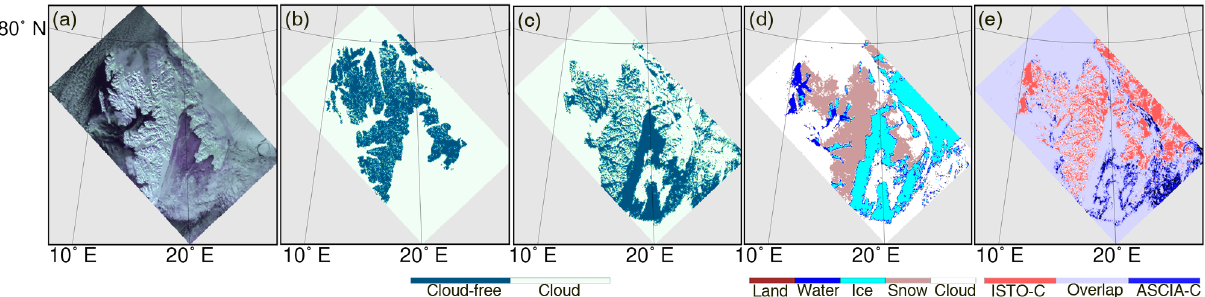
Figure 8. (a) The RGB false-colour image (using 0.67, 0.87 and 0.55µm channels) of AATSR over Svalbard, 18 March 2008; (b) nadir cloud flag from the AATSR L2 product; (c) cloud detection based on the spectral shape of clear snow; (d) cloud detection of ASCIA and (e) the difference between ISTO and